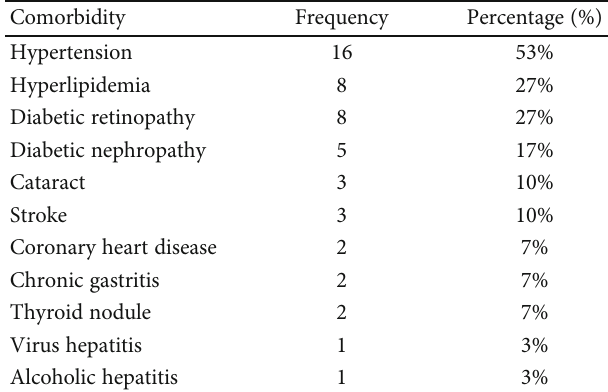
Table 3: Comorbidities of patients.